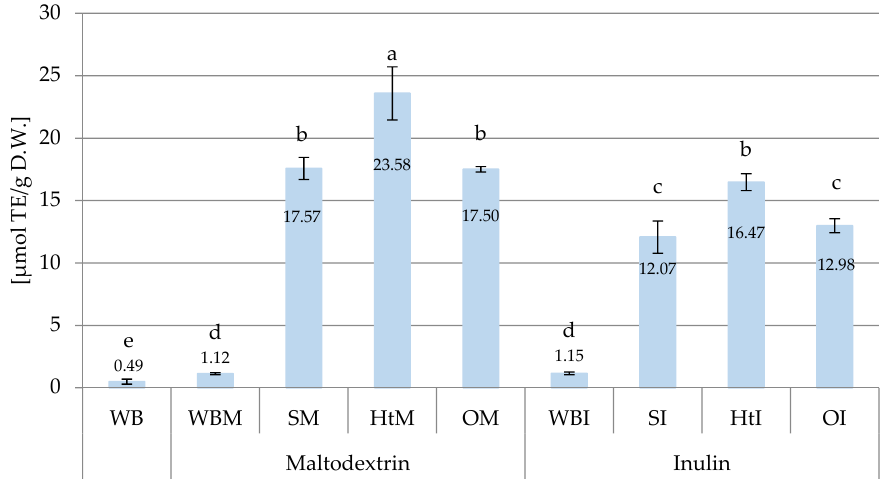
Figure 5. FRAP antioxidant capacity ( μ mol TE/g D.W.) of different samples of wheat bread. Abbreviations: WB—wheat bread; WBM—wheat bread with maltodextrin; SM—wheat bread enriched with soy extracts in maltodextrin; HtM—wheat bread enriched with hawthorn extracts in maltodextrin; OM—wheat bread enriched with onion husk extracts in maltodextrin; WBI—wheat bread with inulin; SI—wheat bread enriched with soy extracts in inulin; HtI—wheat bread enriched with hawthorn extracts in inulin; OI—wheat bread enriched with onion husk extracts in inulin. Values with different letters were significantly different at p = 0.05 according to Duncan’s test. The data are expressed as mean ( n = 3).